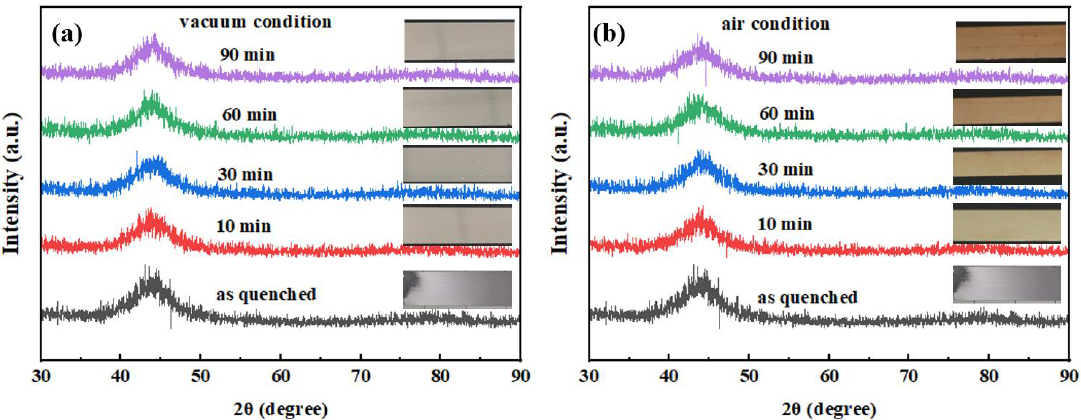
Figure 3. XRD curve and pictures of the FeCoSiBPC amorphous alloy at 280 °C; ( a ) vacuum; ( b ) non-vacuum.